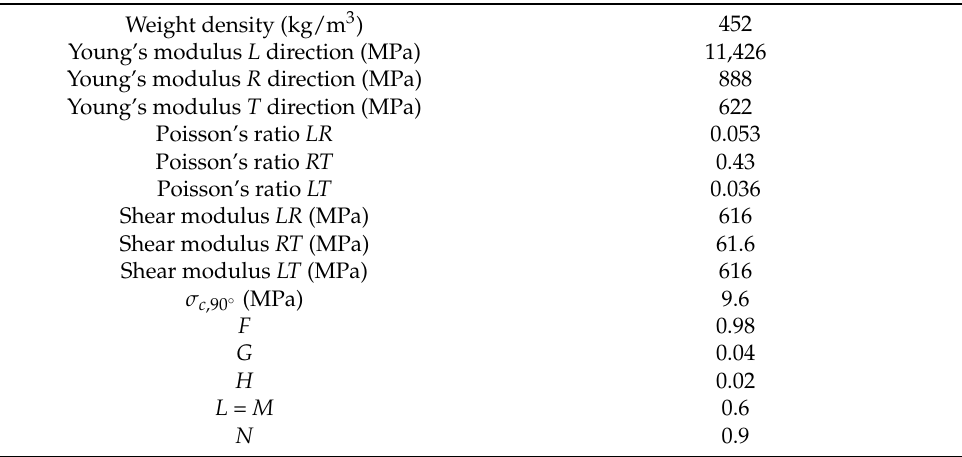
Table 2. Material properties of timber [27,30] used in the